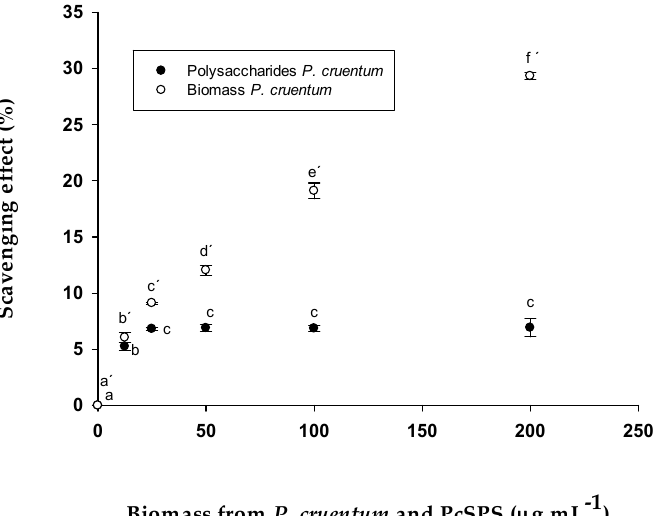
Figure 2. Scavenging effects % of the sample of biomass from P. cruentum and PcSPs on ABTS radical. Different points with the same letter correspond to different concentrations with no significant differences between them (post-hoc Tukey HSD test).